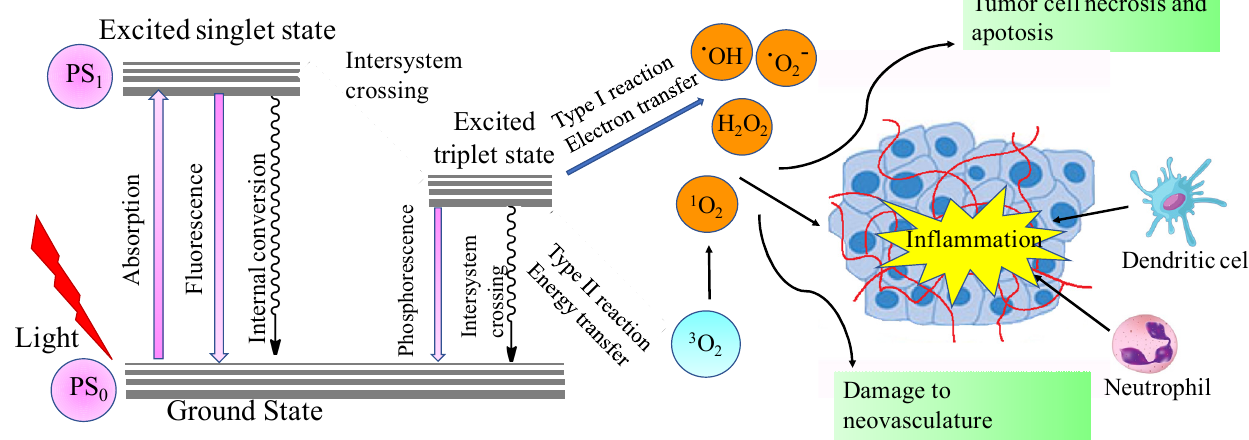
Figure 1. Modified Jablonski scheme illustrating the principles and mechanisms of photodynamic therapy. Reprinted with permission from Ref. [8]. Copyright 2006 Springer Nature.